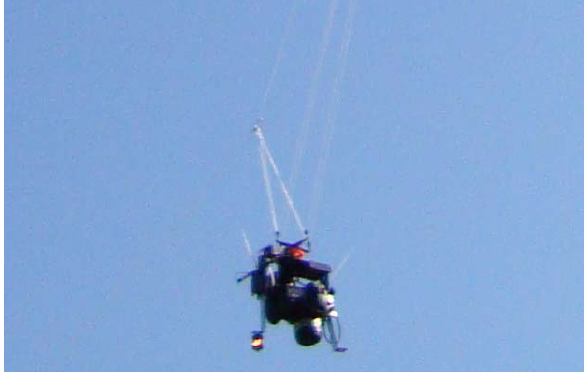
Figure 3. Detail of the platform, camera and 360º Leica miniprism (NCP